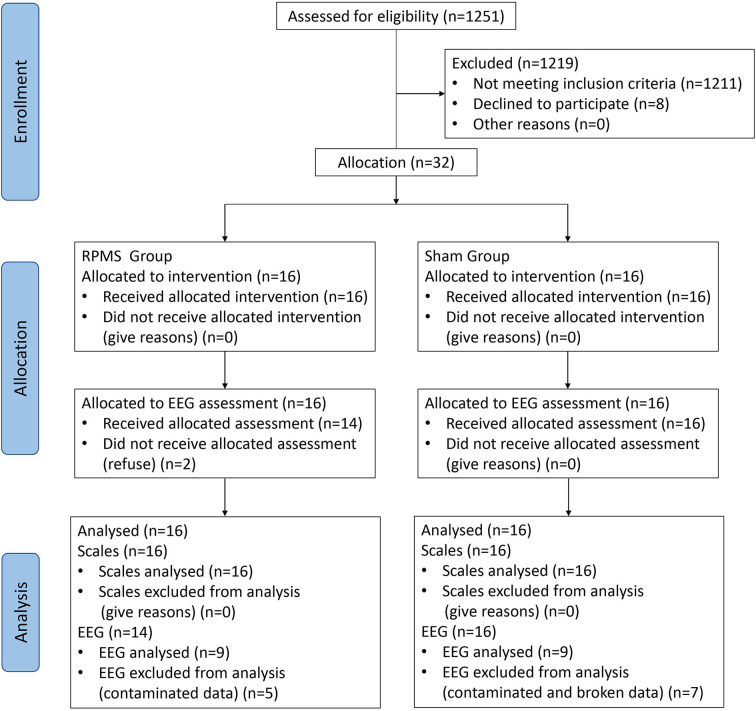
Flow chart of the study sample and procedures of the rPMS and sham groups.